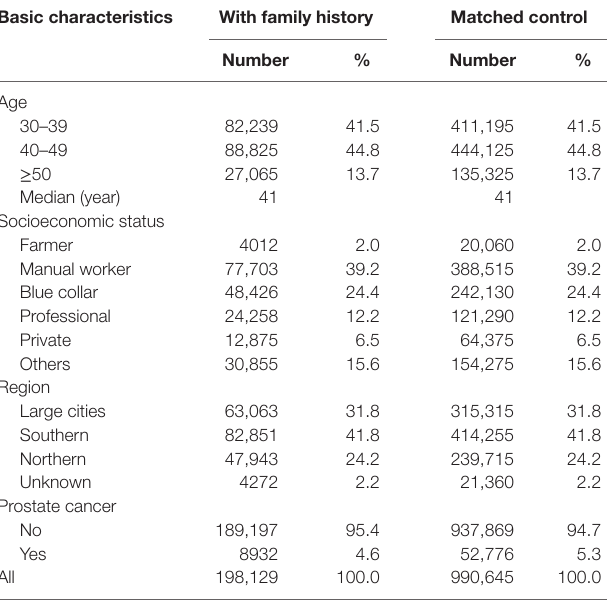
TaBle 1 | Basic characteristics among men with a family history of type 2 diabetes and matched